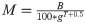
Seeding blood-stage parasitaemia with infected red blood cells (iRBC) to obtain an estimate of blood-stage growth rate by non-linear curve fitting.Dilution series of PvCSP-210/PvTRAP transgenic P. berghei iRBC were intravenously injected into 6–8 week old BALB/c mice (n = 34) and time to 1% blood stage parasitaemia inferred by linear regression from daily thin blood smears. Curve-fitting to the equation M=B100*gT+0.5 was performed using Prism to obtain a value for the growth rate g where M is the number of iRBC injected, T time-to-1% in the challenged mouse, and B the average number of RBC in a 22 g BALB/c mouse. A value of g = 3.50 ± 0.12 (SEM) was obtained.